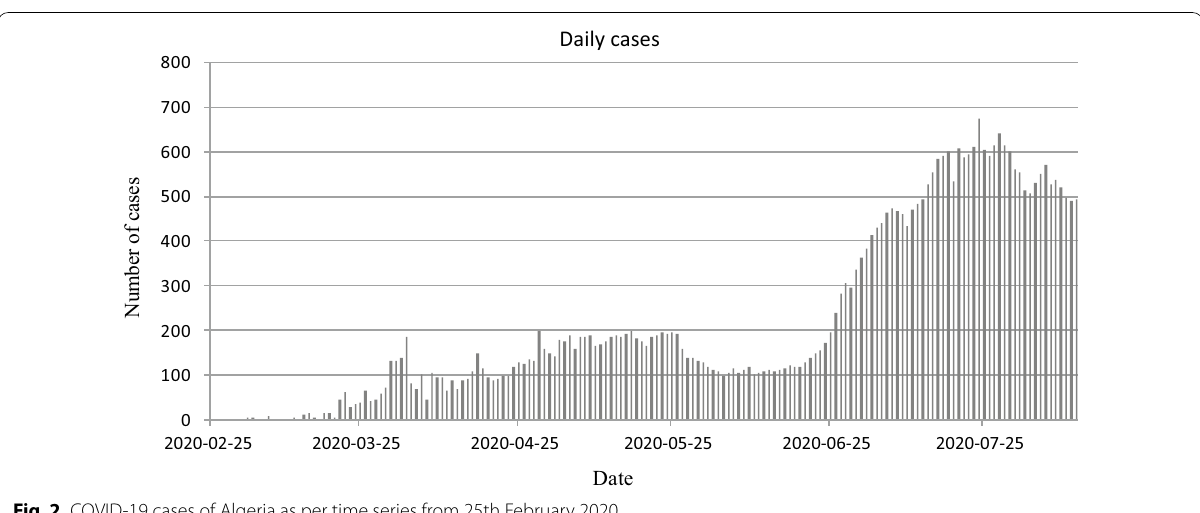
Fig. 2 COVID-19 cases of Algeria as per time series from 25th February 2020